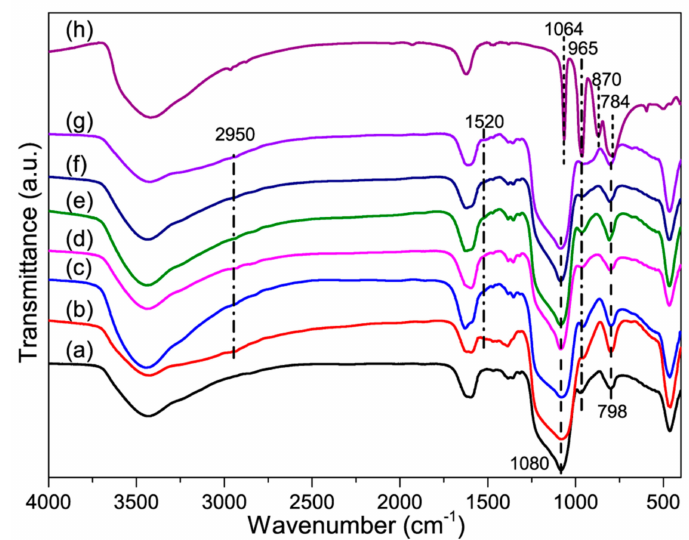
Figure 1. Fourier transform infrared (FT-IR) spectra of ( a ) SBA-15, ( b ) NH 2 -SBA-15, ( c ) 3.3PMo / NH 2 -SBA-15, ( d ) 6.7PMo / NH 2 -SBA-15, ( e ) 10PMo / NH 2 -SBA-15, ( f ) 13.3PMo / NH 2 -SBA-15, ( g ) 16.7PMo / NH 2 -SBA-15, and ( h ) H 3 PMo 12 O 40 · nH 2 O.